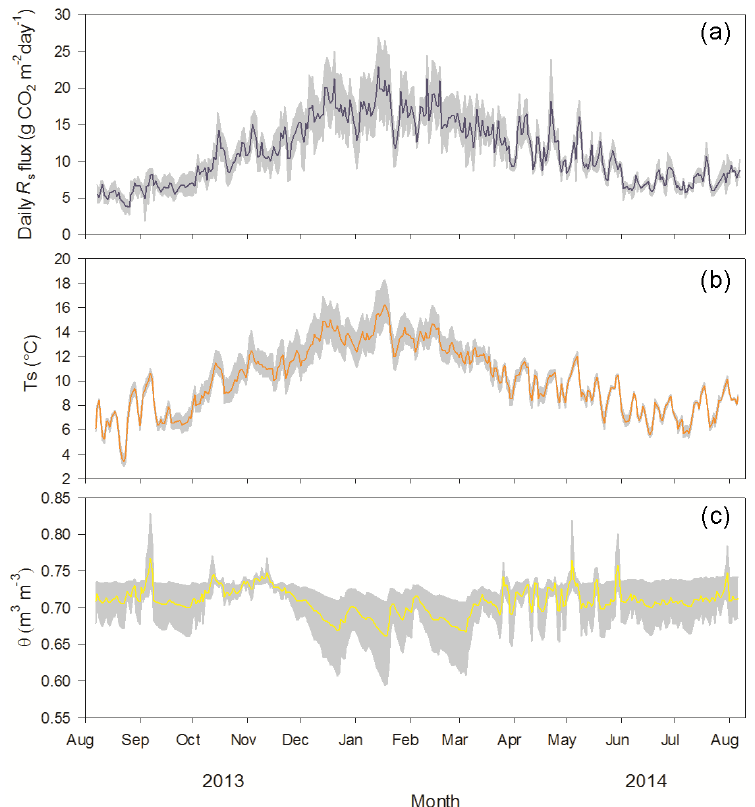
Figure 4. Daily mean R s (a) , soil temperature (b) and soil water content (c) . The shaded area represents the minimum and maximum range of three sampling